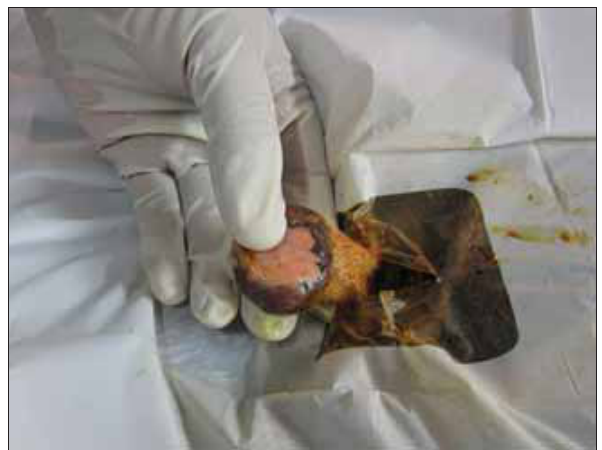
Figure-2: Exposed tumor mass at the left belly fold.